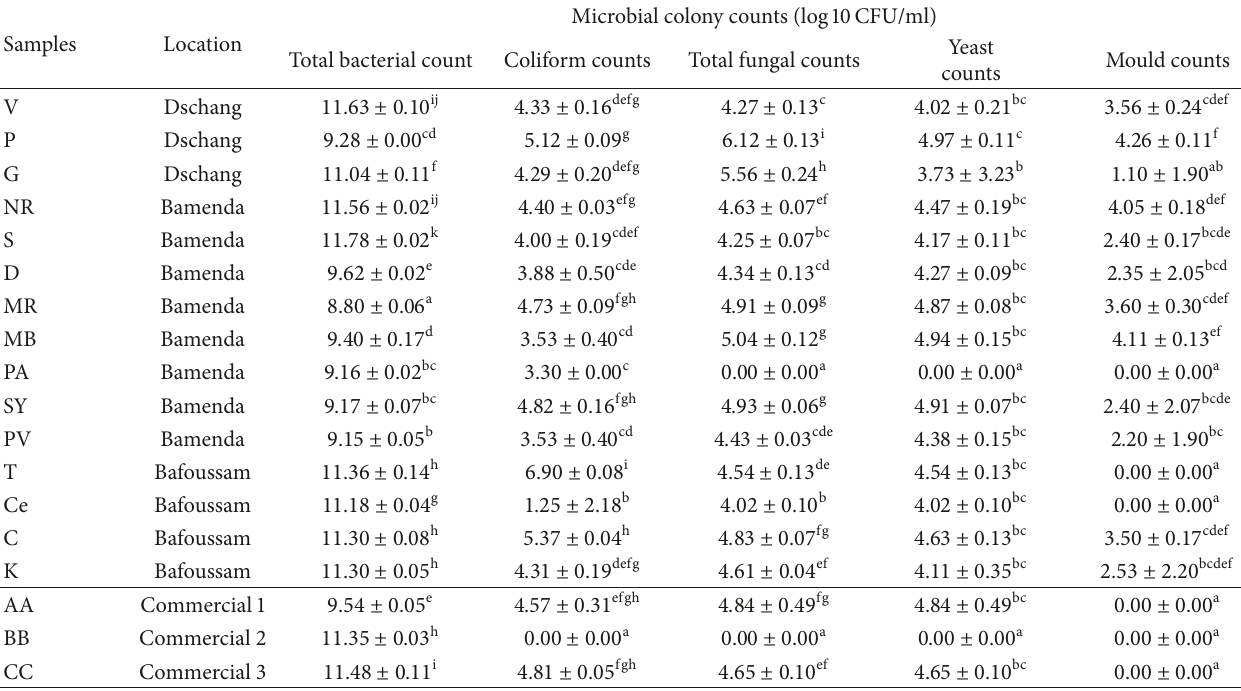
Table 1: The microbial quality of yoghurt samples as a function of production area and producer during the dry season (I).